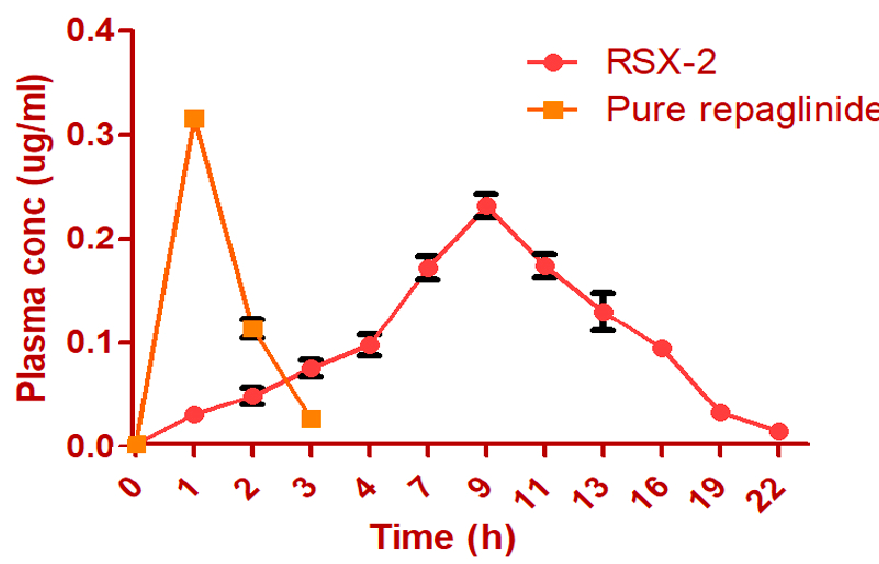
Figure 10. A typical chromatogram of repaglinide by RP-HPLC.